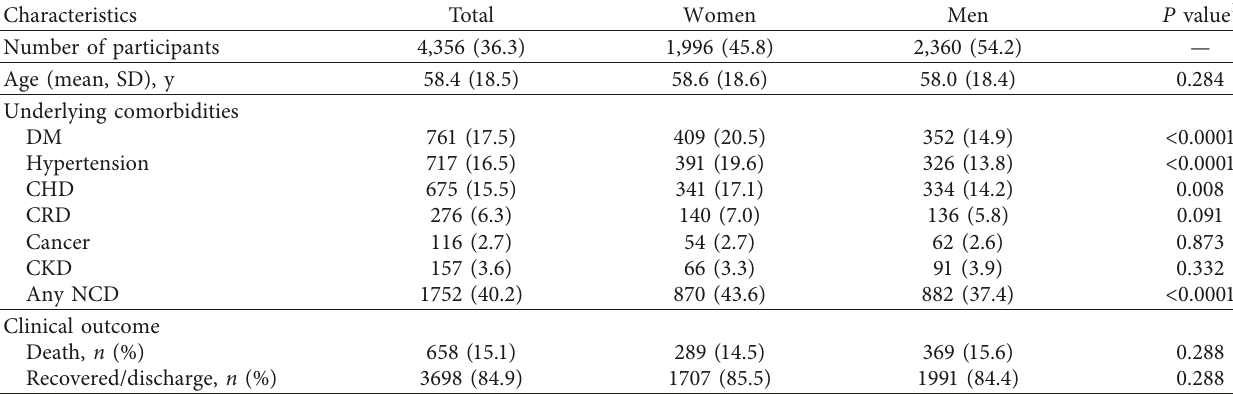
Table 1: Basic characteristics and comorbidities frequency of hospitalized patients with positive real-time reverse-transcription polymerase chain reaction test results for COVID-19.